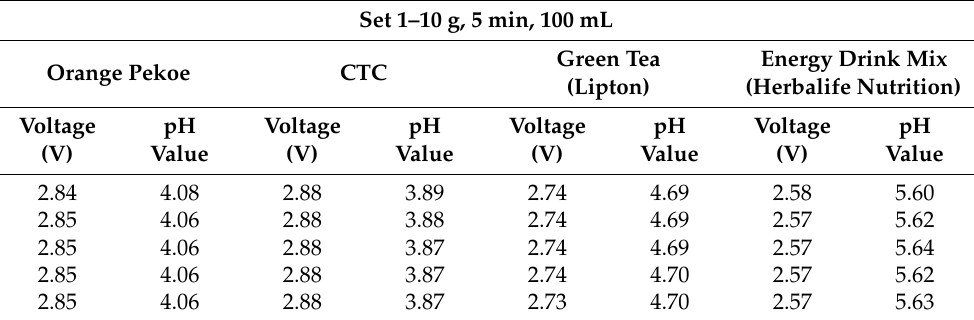
Figure 15. Tea infusion (Set 3–10 g, 5 min, 230 mL). Table 4. pH value and the corresponding port voltage for Set 1–10 g, 5 min, 10 mL.